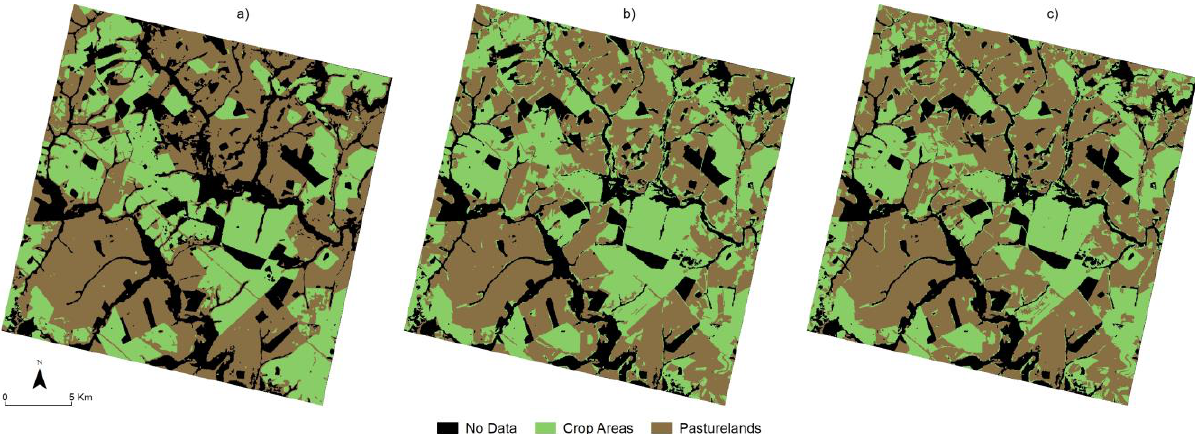
Figure 8. Comparison between: a) Mapbiomas classification; b) 83 attributes classification; and c) 37 attributes